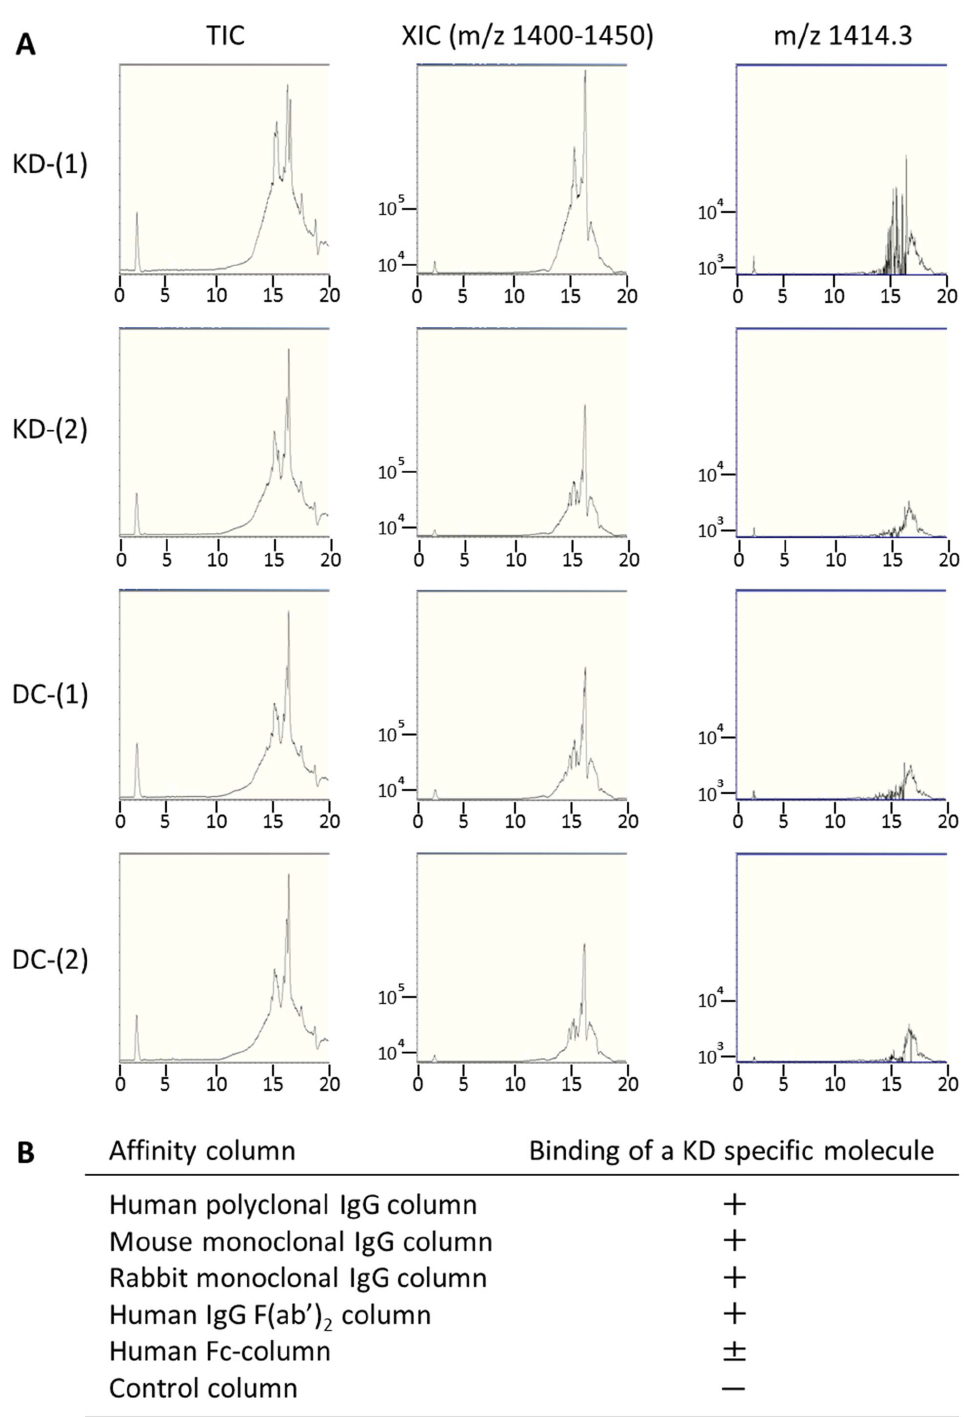
Figure 5. LC-MS chromatograms of IgG sepharose-binding molecules. A. Representative LC-MS chromatograms of a IgG sepharose-binding molecule (m/z 1414.3) are shown in a KD patient and a DC control. TIC: Total ion current chromatograms, XIC: Extracted-ion chromatograms at m/z 1400–1500, and extracted-ion chromatograms at m/z 1414.3. (1) Human polyclonal IgG-conjugated sepharose 6 Fast (2) Inactivated CNBr Sepharose 4B control column. B. Binding of a KD-specific molecule to various affinity columns: Columns used are described in ONLINE METHODS. + : The binding quantities of a KD-specific molecule analyzed by LC-MS were equal or larger than those to human polyclonal IgG column, 6 : smaller than 20% of those to human polyclonal IgG column, -: no binding. We performed the experiments 3 times.